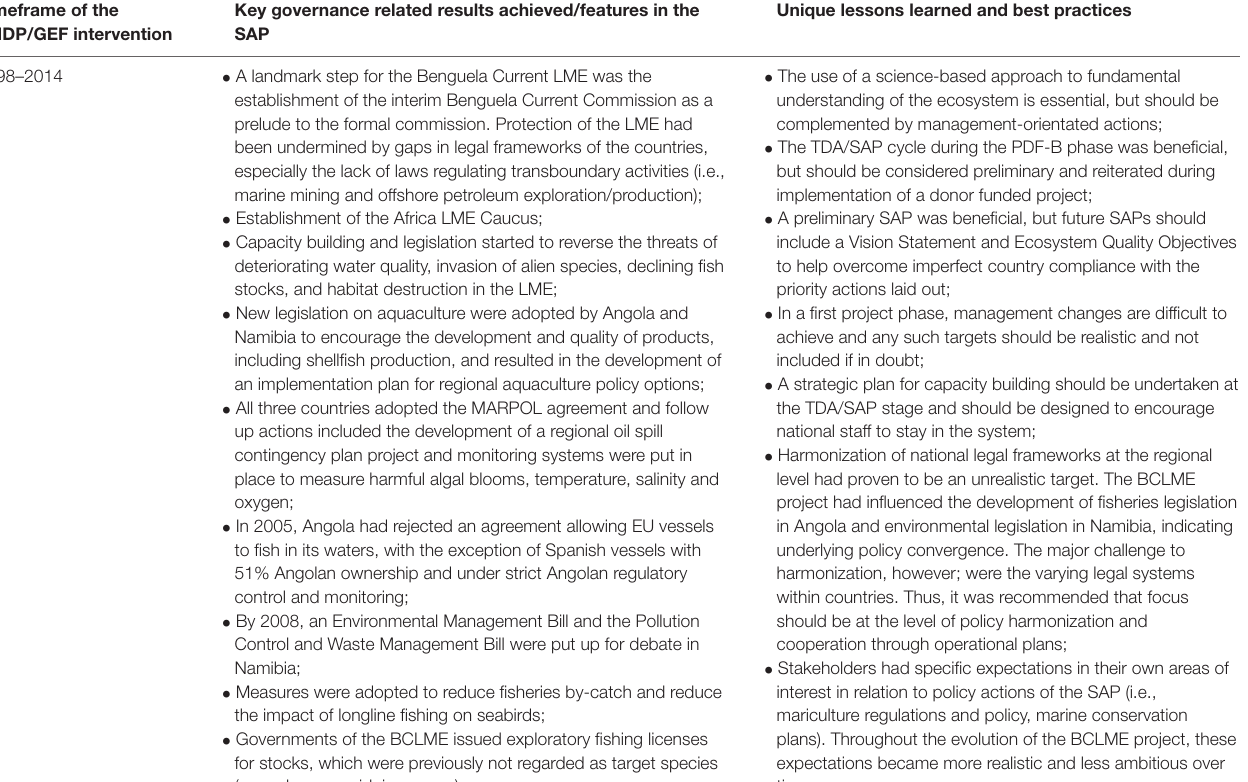
TABLE 2 | Highlighted results of the TDA-SAP process and LME Approach in the Benguela Current LME, as well as unique lessons learned from the intervention (United Nations Development Programme, 2008; United Nations Development Programme, 2012a). Timeframe of the UNDP/GEF